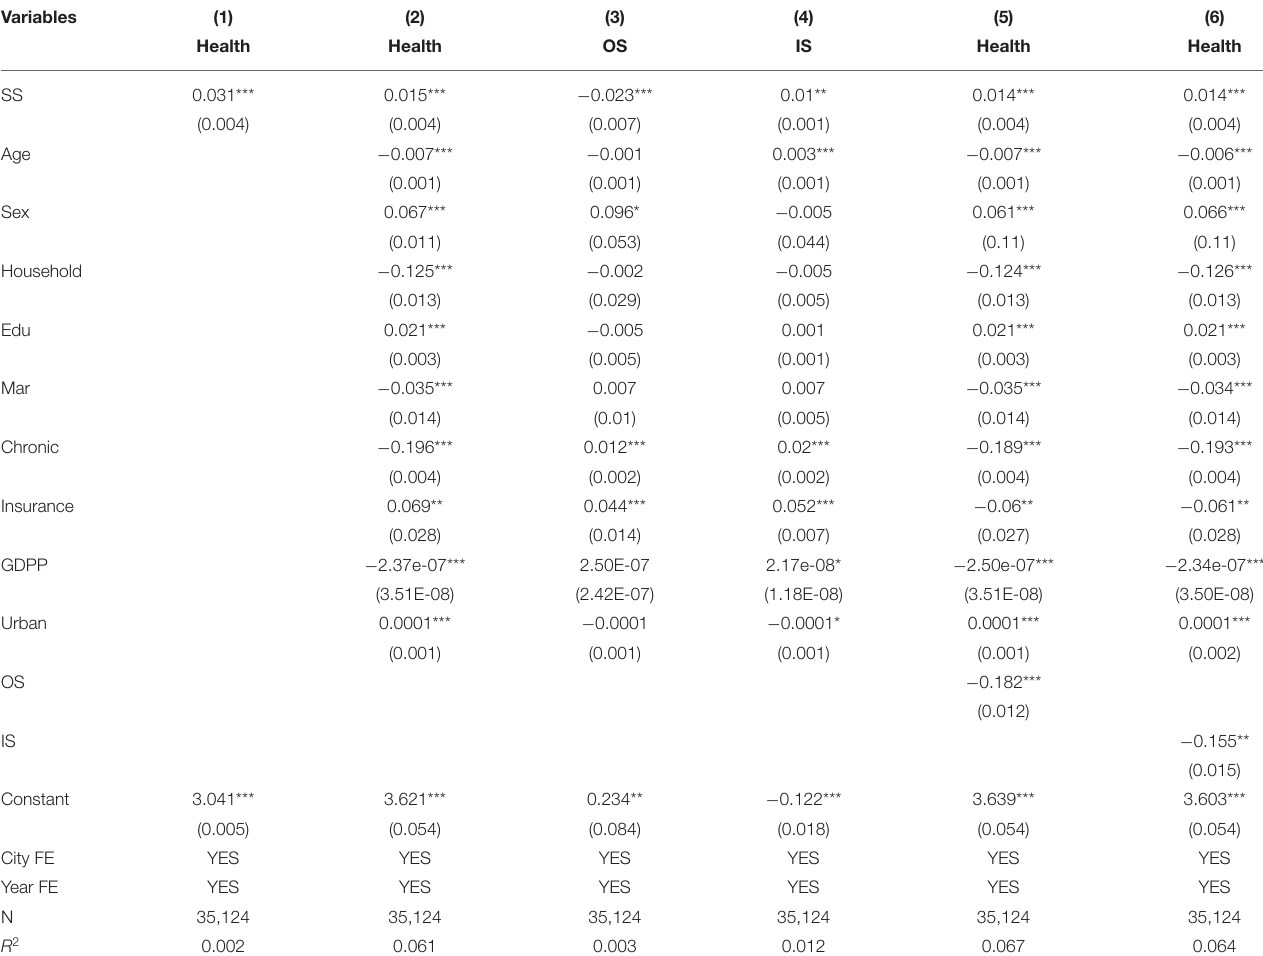
TABLE 4 | The results of benchmark regression and mediating effects.